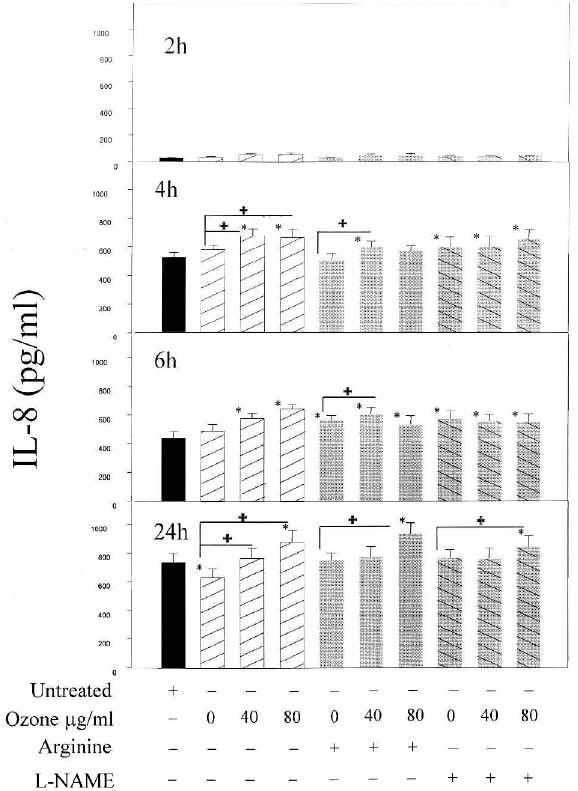
FIG. 6. Kinetics of release of IL-8 from HUVECs after addition of human serum either after oxygenation or after ozonation. Effect of the addition of L-arginine and L-NAME. The data are presented as the arithmetic mean ±SD of 6 different